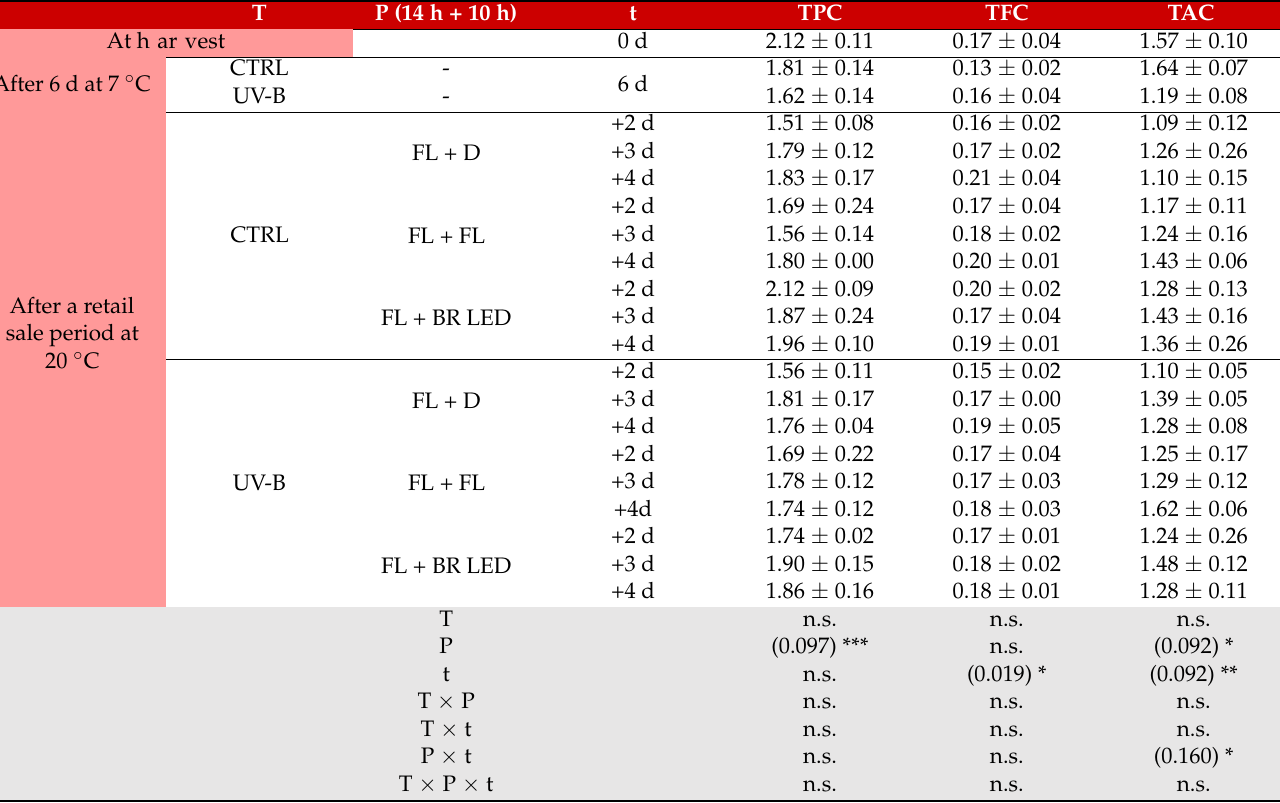
Figure 2. Sensory analysis of untreated and UV-B-treated bell peppers after 6 d at 7 ◦ C and after a complimentary retail sale period of 4 d at 20 ◦ C as mean values under all light conditions, which did not reported differences. * denotes statistical differences ( p < 0.05). A 5-point hedonic scale was used, with 1 meaning ‘Extremely bad’, 3 ‘Limit of commercialization’, and 5 ‘Excellent’. Table 3. Total phenolic compounds (g gallic acid equivalents kg − 1 ), total flavonoid compounds (g rutin equivalents kg − 1 ), and total antioxidant capacity (g trolox equivalents kg − 1 ) of UV-B-treated and untreated (CTRL) bell peppers during a storage and transportation period of 6 d at 7 ◦ C followed by a retail sale period of 2, 3, or 4 d at 20 ◦ C under a photoperiod of 14 h in fluorescent light + 10 h in different light